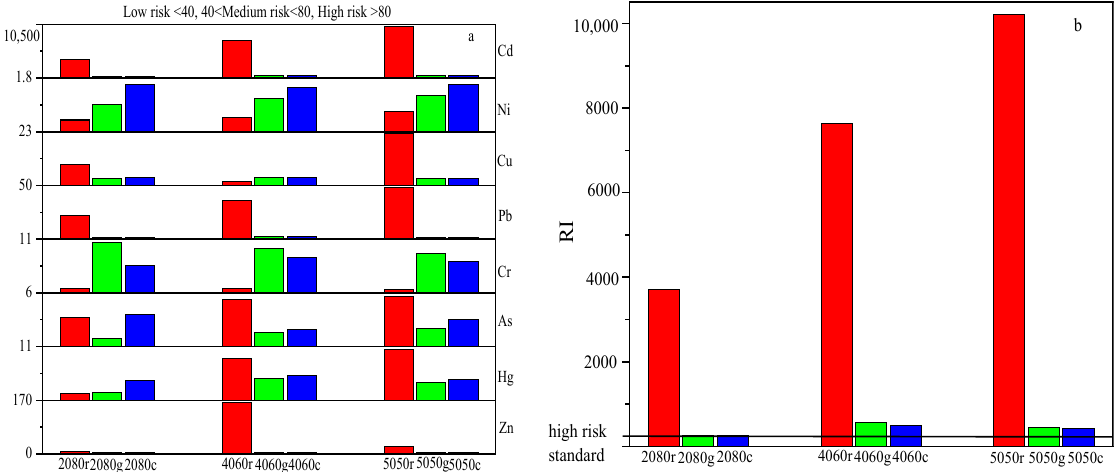
Figure 6. ( a ) Single HM potential ecological risk level and ( b ) multi metal potential ecological risk index (RI).